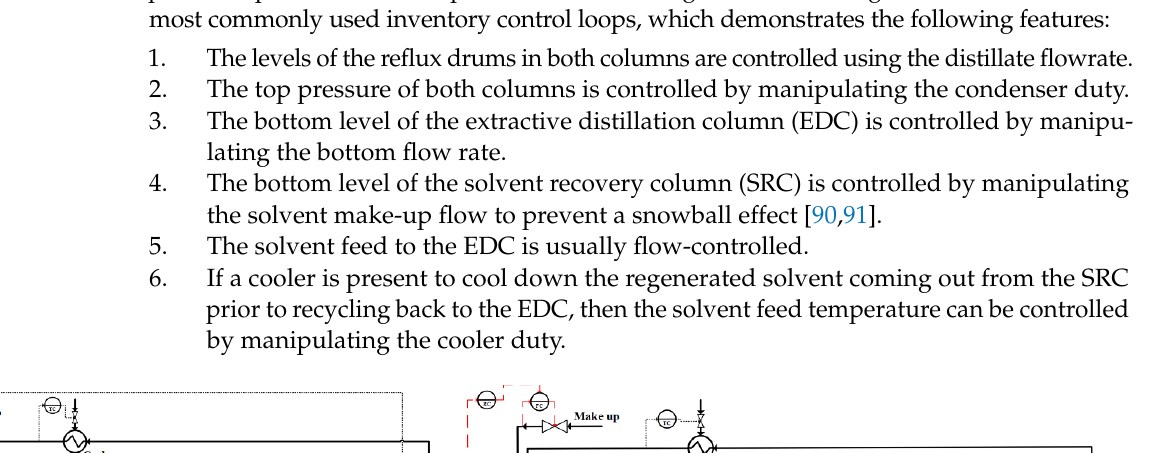
10 of 21 Figure 3. General procedures for evaluating process flowsheets. In the following subsections, the abovementioned methodology is illustrated using